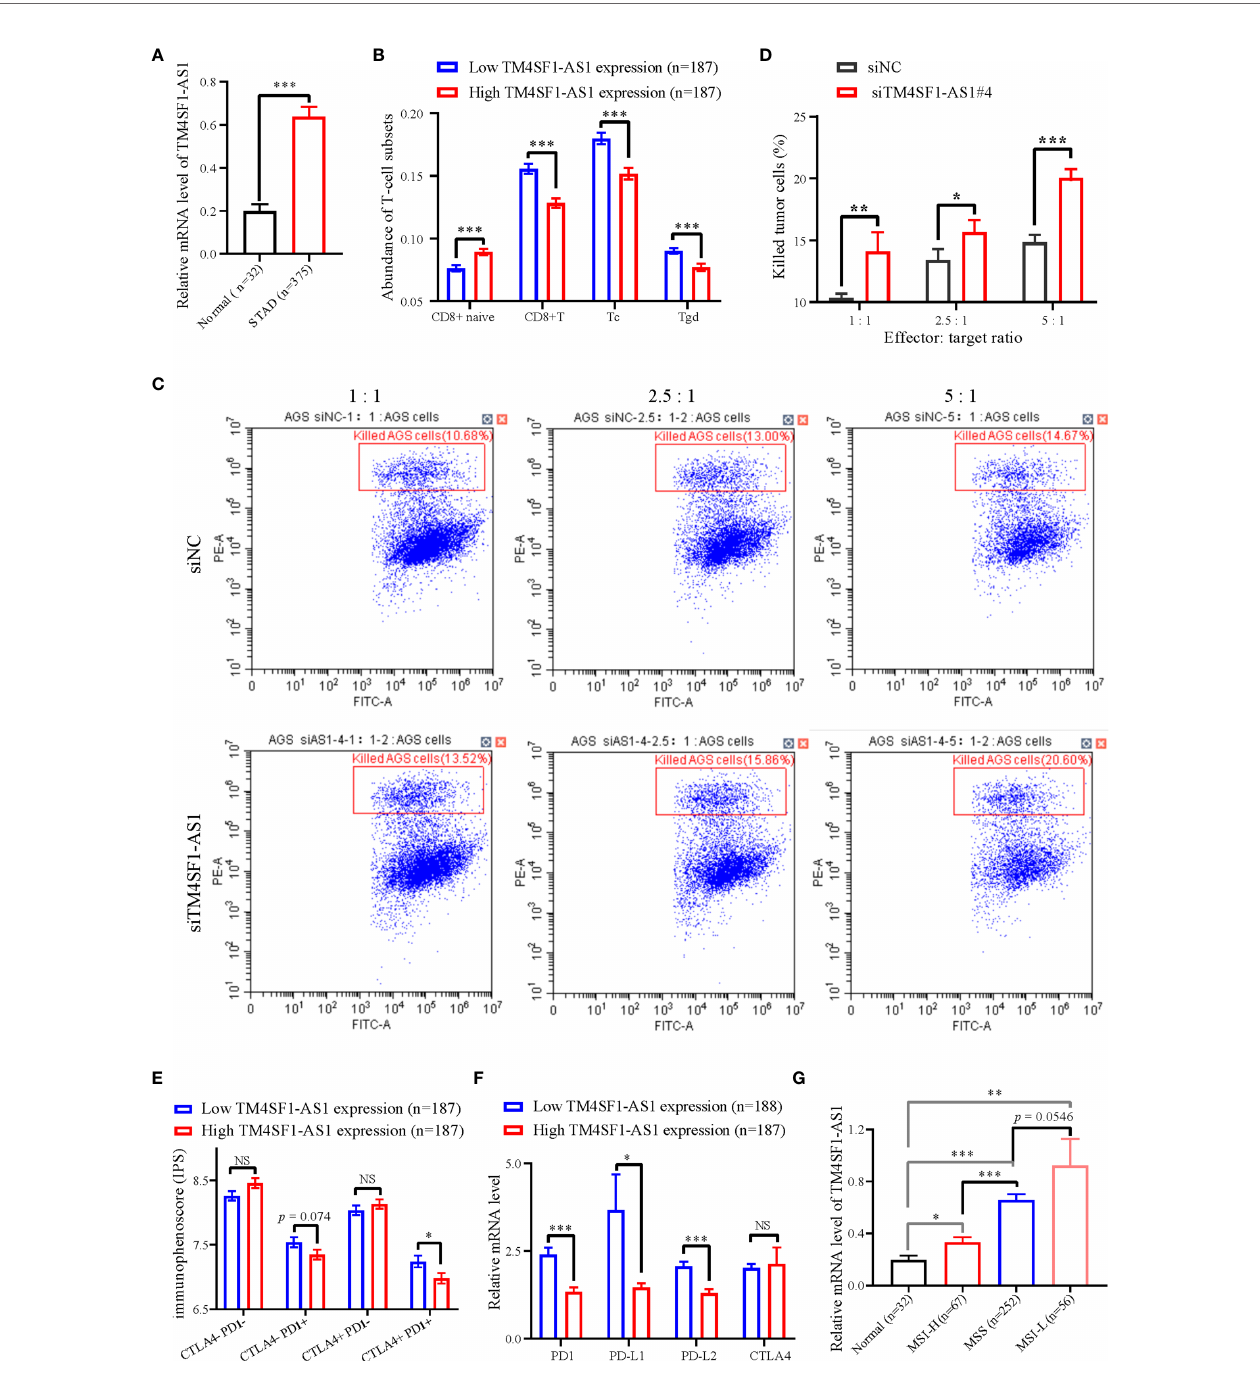
FIGURE 6 | The expression of TM4SF1-AS1 and its role in the tumor immune microenvironment in STAD. (A) Expression changes of TM4SF1-AS1 in human STAD samples compared with normal samples. (B) The abundance of CD8+ T cell between high and low expression of TM4SF1-AS1. (B, C) Flow cytometry showing the effect of TM4SF1-AS1 knockdown on the killing activities of activated T cells in AGS cells. (C) Immunophenoscore of CTLA- PD1-, CTLA- PD1+, CTLA+ PD1- and CTLA+ PD1+ patients in the groups with high and low TM4SF1-AS1 expression, respectively. (D) Expression of PD1, PD-L1, PD-L2 and CTLA4 in the high and low TM4SF1-AS1 expression groups. (E) Expression of TM4SF1-AS1 in groups among normal tissues, MSI-H, MSS and MSI-L. (F) Expression of PD1, PD-L1, PD-L2 and CTLA4 in the high and low TM4SF1-AS1 expression groups. (G) Expression of TM4SF1-AS1 in groups among normal tissues, MSI-H, MSS and MSI-L. The expression of TM4SF1-AS1, PD1, PD-L1, PD-L2 and CTLA4 were downloaded from TCGA database (https://www.cancer.gov/). Immunophenoscore information of CTLA- PD1-, CTLA- PD1+, CTLA+ PD1- and CTLA+ PD1+ patients were downloaded from TICA database (https://tcia.at/home). NS stands for “ no signi fi cance ” , * refers to p < 0.05, ** indicates p < 0.01, and *** signi fi es p <